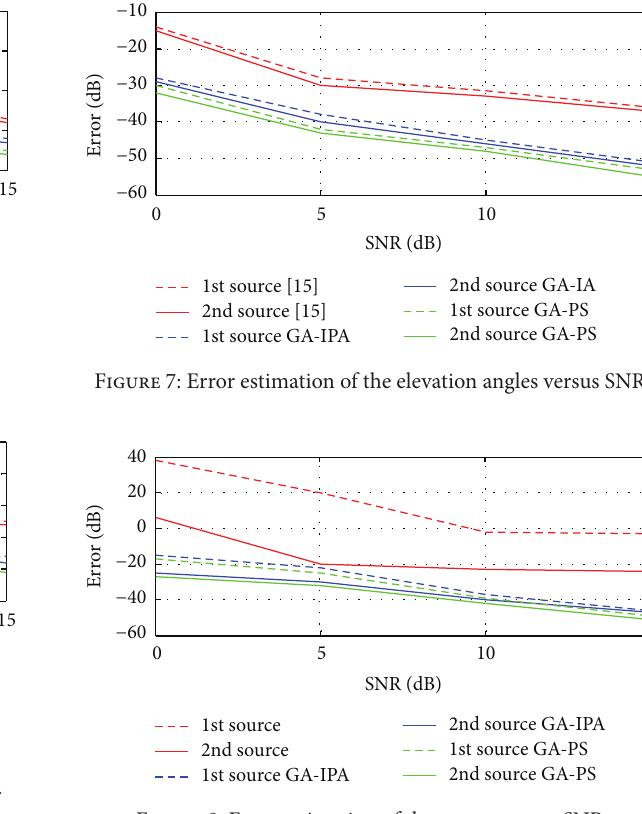
Figure 8: Error estimation of the ranges versus